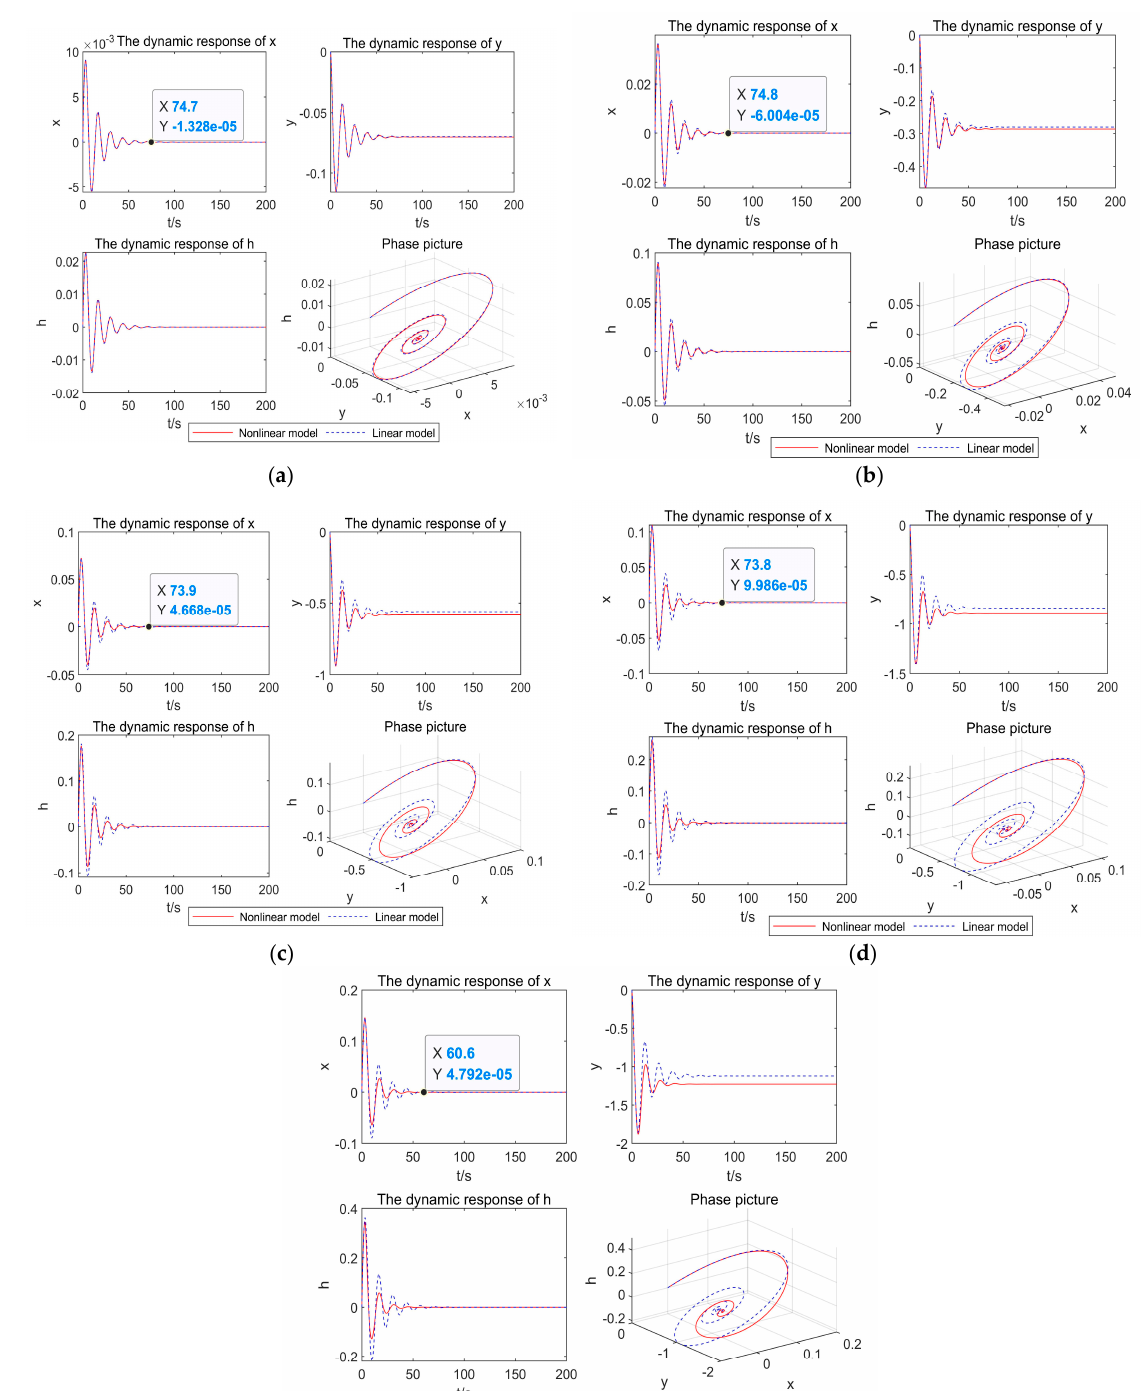
Figure 6. Dynamic response of linear and nonlinear models with load rejection: ( a ) 5%; ( b ) 20%; ( c ) 40%; ( d ) 60%; ( e ) 80%. ( c ) 40%; ( d ) 60%; ( e )